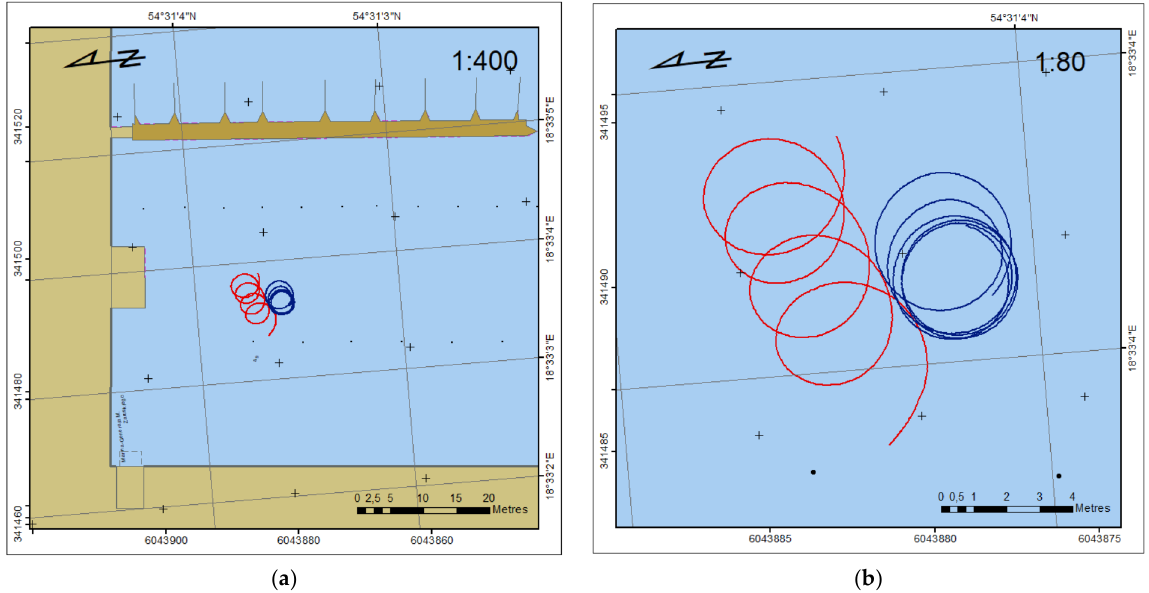
Figure 12. Trajectory of USV during circulations in two scales: small ( a ) and large ( b ). Figure 13 presents headings and COG during 90 s of rotation of the USV to the right (a) and 120 s of rotation to the left. During measurements, the USV rotated four times right and five times left.